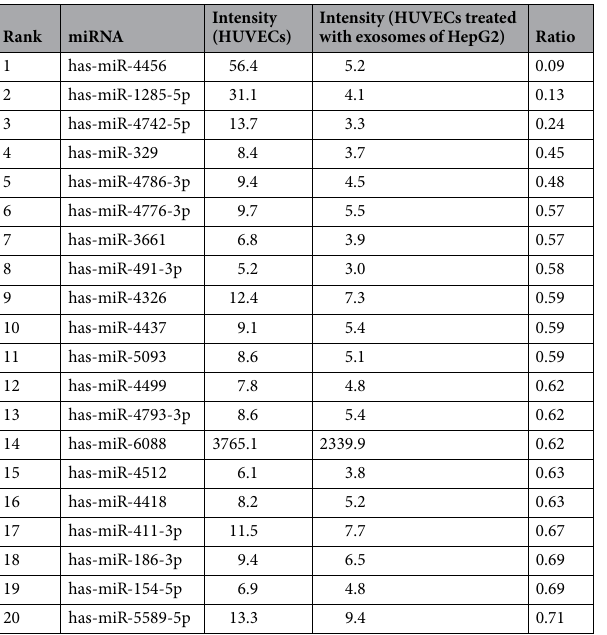
Table 3. Top20 down-regulated microRNAs derived from HUVECs treated with exosomes of HepG2 cells. Ratio: Intensity of miRNA derived HUVECs treated with exosomes of HepG2/Intensity of miRNA derived from HUVECs.